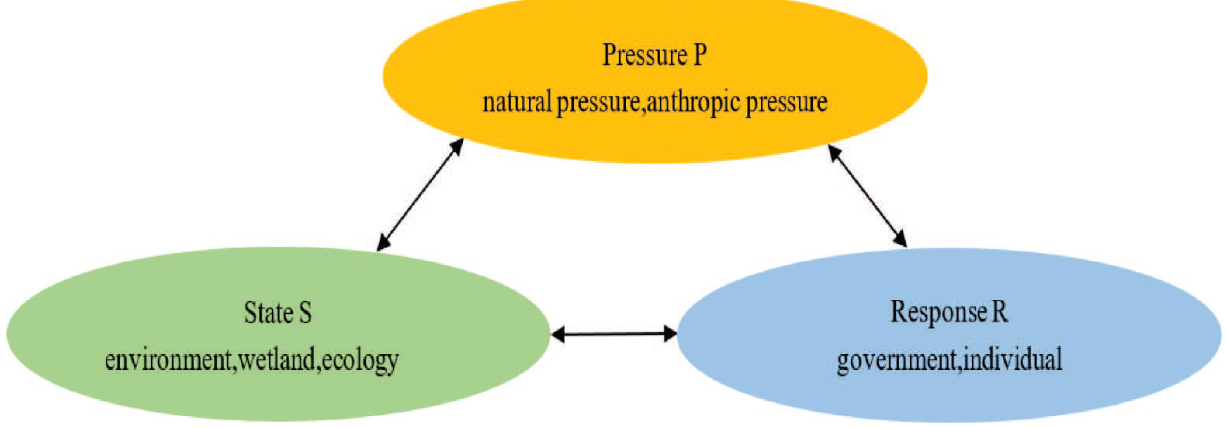
Fig. 2 PSR model logic